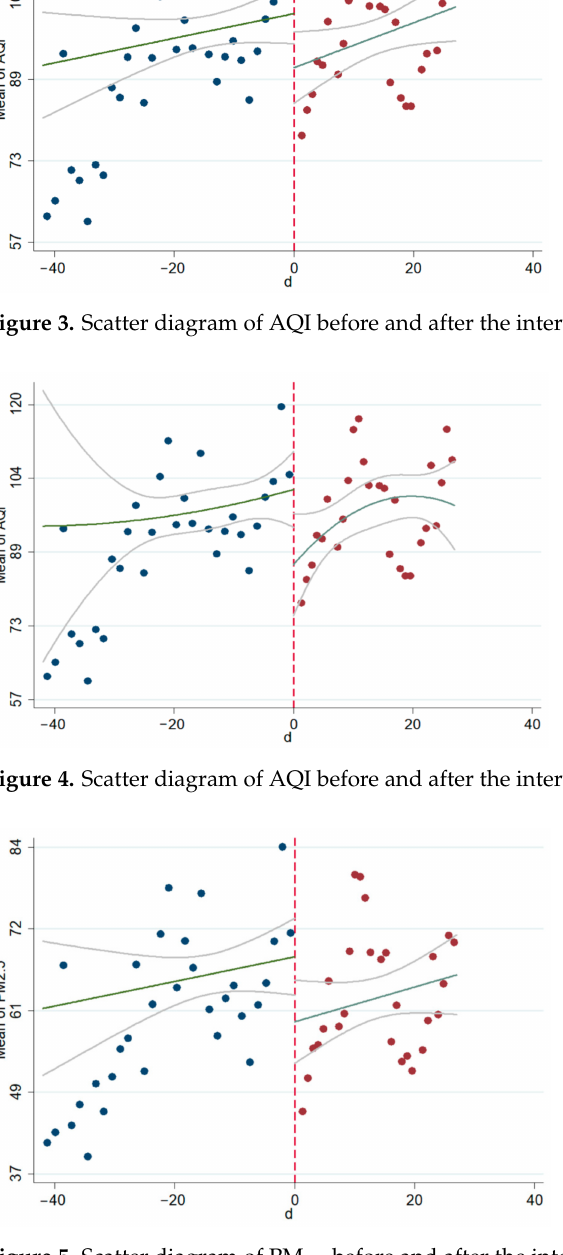
Figure 5. Scatter diagram of PM 2.5 before and after the interviews